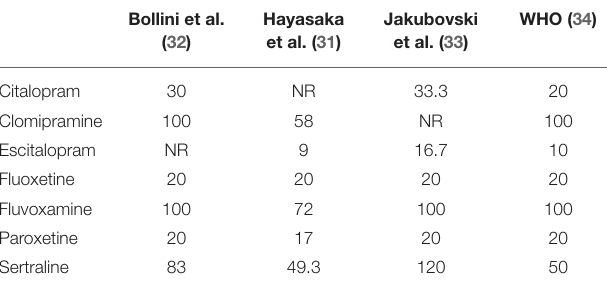
TABLE 1 | Antidepressant dose equivalence (mg) according to previous